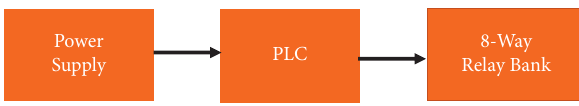
Figure 2: Block diagram of the controller unit.